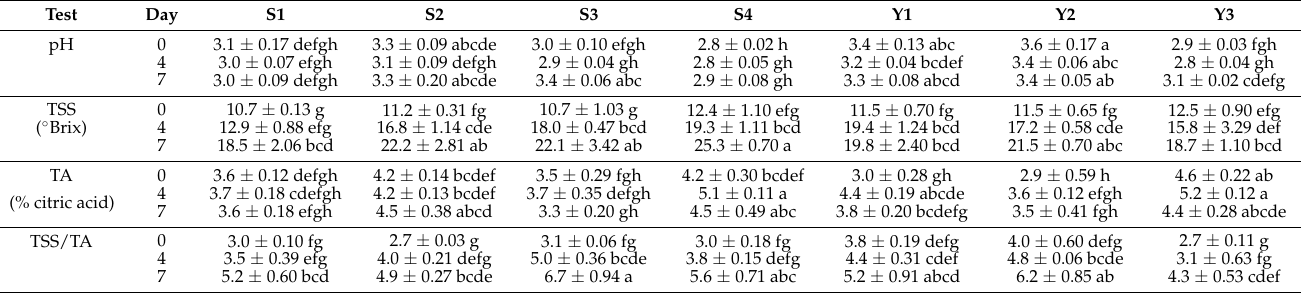
Table 4. pH, TA and TSS of the studied BP during ambient